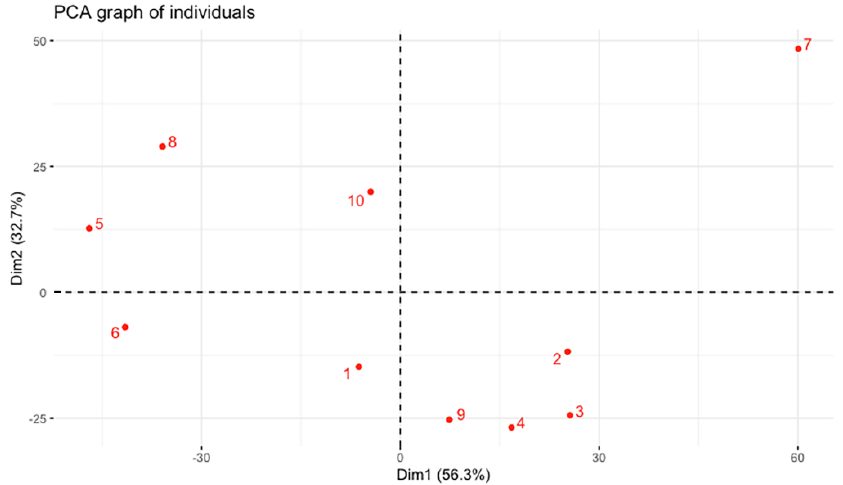
Figure 12. PCA of individual observations for the data in the FTIR spectrum: 1—G1; 2—G2; 3—G3;